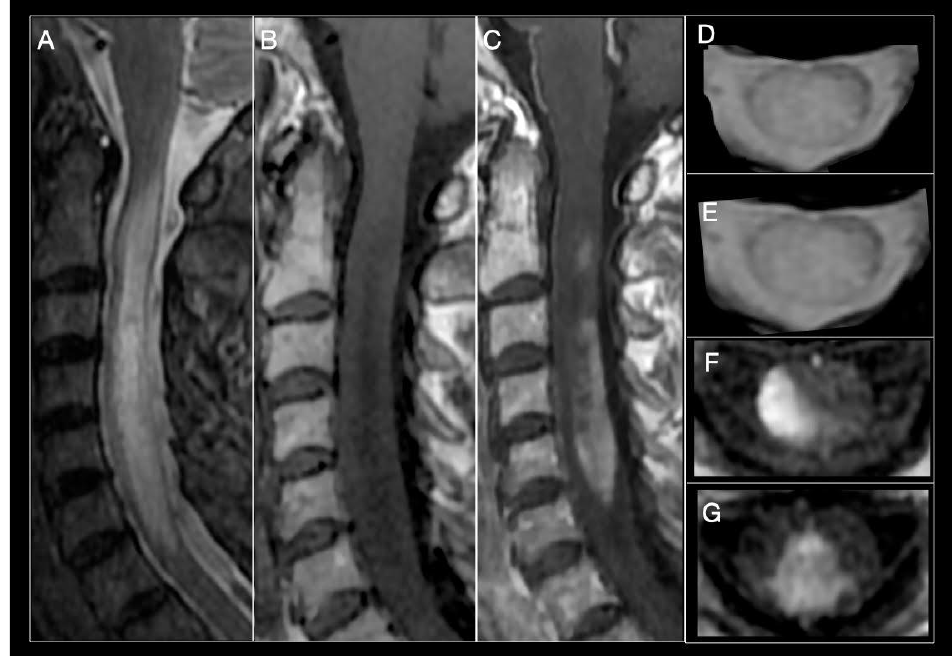
Figure 2. Neuromyelitis optica (NMO) myelitis. Images from a 58-year-old woman with acute longitudinally extensive myelitis (C1–C7). ( A ) Sagittal STIR showing an extensive lesion, involving more than 3 segments, that widens the cervical spinal cord. ( B ) Sagittal T1-weighted sequences show an extensive T1-hypointense lesion. ( C ) T1-weighted images after contrast administration, extensive enhancement of cervical lesion. ( D , E ) Axial T2-MERGE hyperintense area that involves more than half the diameter of the spinal cord. ( E , F ) Axial T1-weighted, intense contrast enhancement of lateral ( E ) and central-posterior ( F , G ) areas.